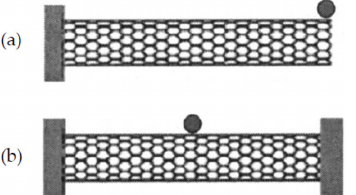
Figure 4. ( a ) Cantilevered and ( b ) simply supported carbon nanotube resonators with an attached mass. Adapted with permission for [126], copyright AIP Publishing, 2004.